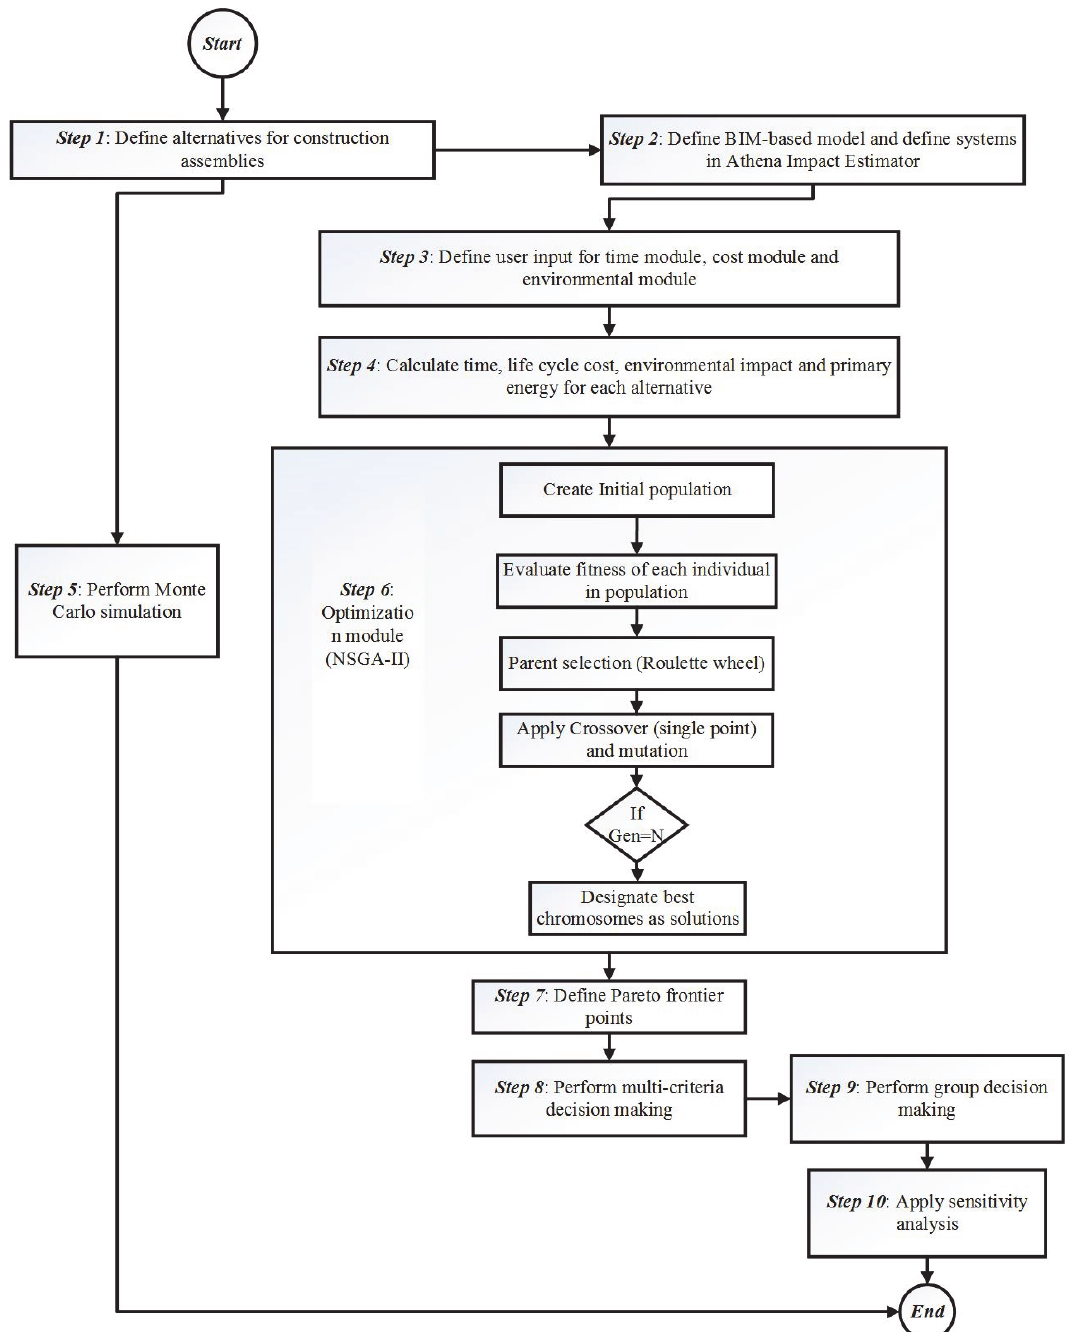
Fig. 1. Framework of the proposed